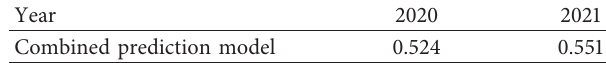
Table 8: Civil aviation incident rates of years 2020 and